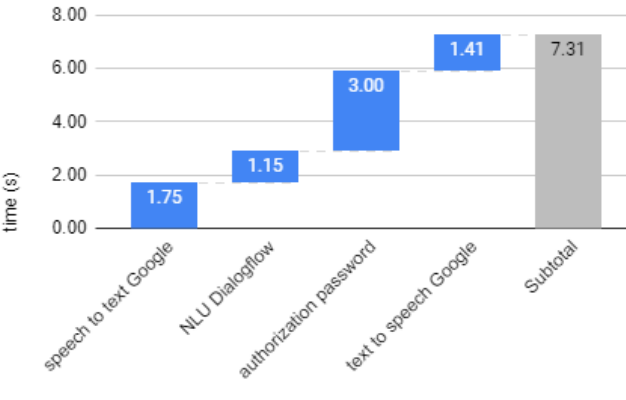
Figure 9. Total response time in the existing scenario: closed architecture and invasive